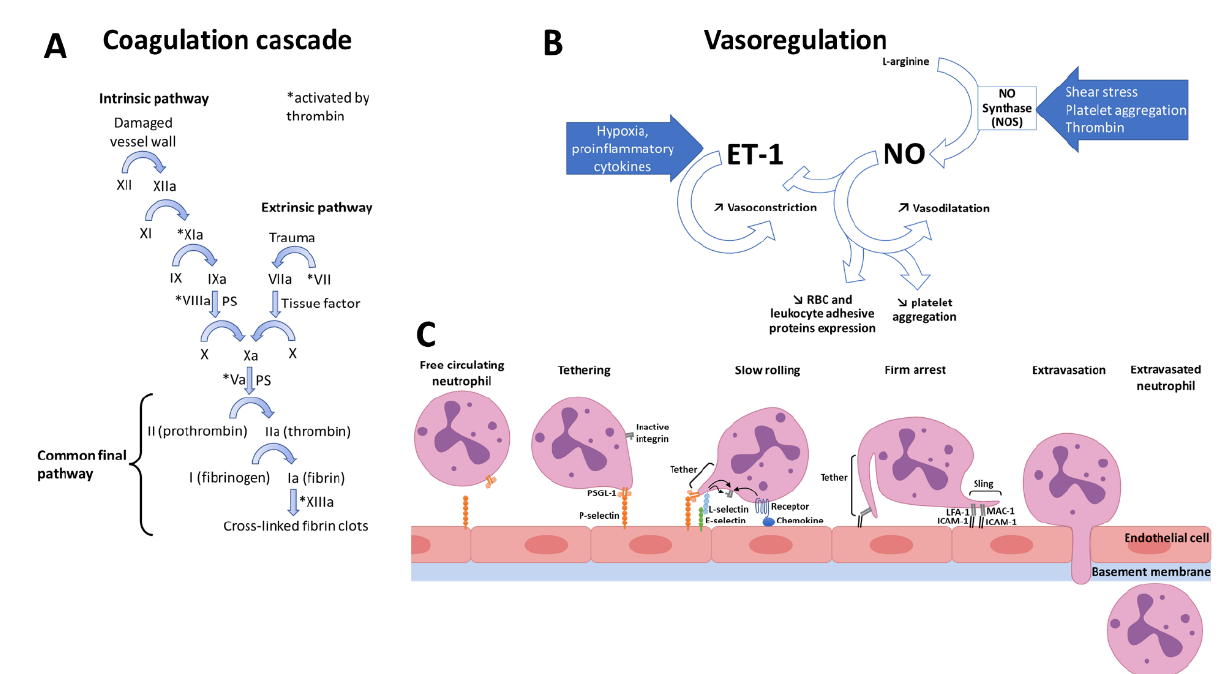
Figure 2. Physiological coagulation cascade activation, vasoregulation, and diapedesis. ( A ) Coagulation cascade relies on the activation several factors and is composed of two pathways, the intrinsic, and the extrinsic one, which both lead to the common final pathway; ( B ) Vasoregulation is mainly regulated by the balance between the vasoconstrictor endothelin-1 (ET-1), and the vasodilator nitric oxide (NO), which inhibits ET-1; ( C ) During diapedesis, free circulating neutrophil are tethered, then they start rolling slower and slower due to their tethers and slings, until their firm arrest. Hereafter they crawl to find the exit location where they are extravasated.